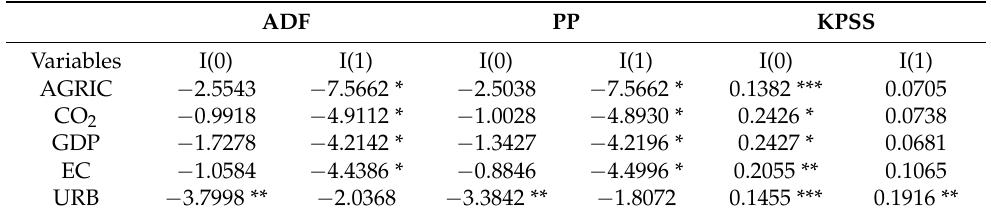
Table 2. ADF and PP.